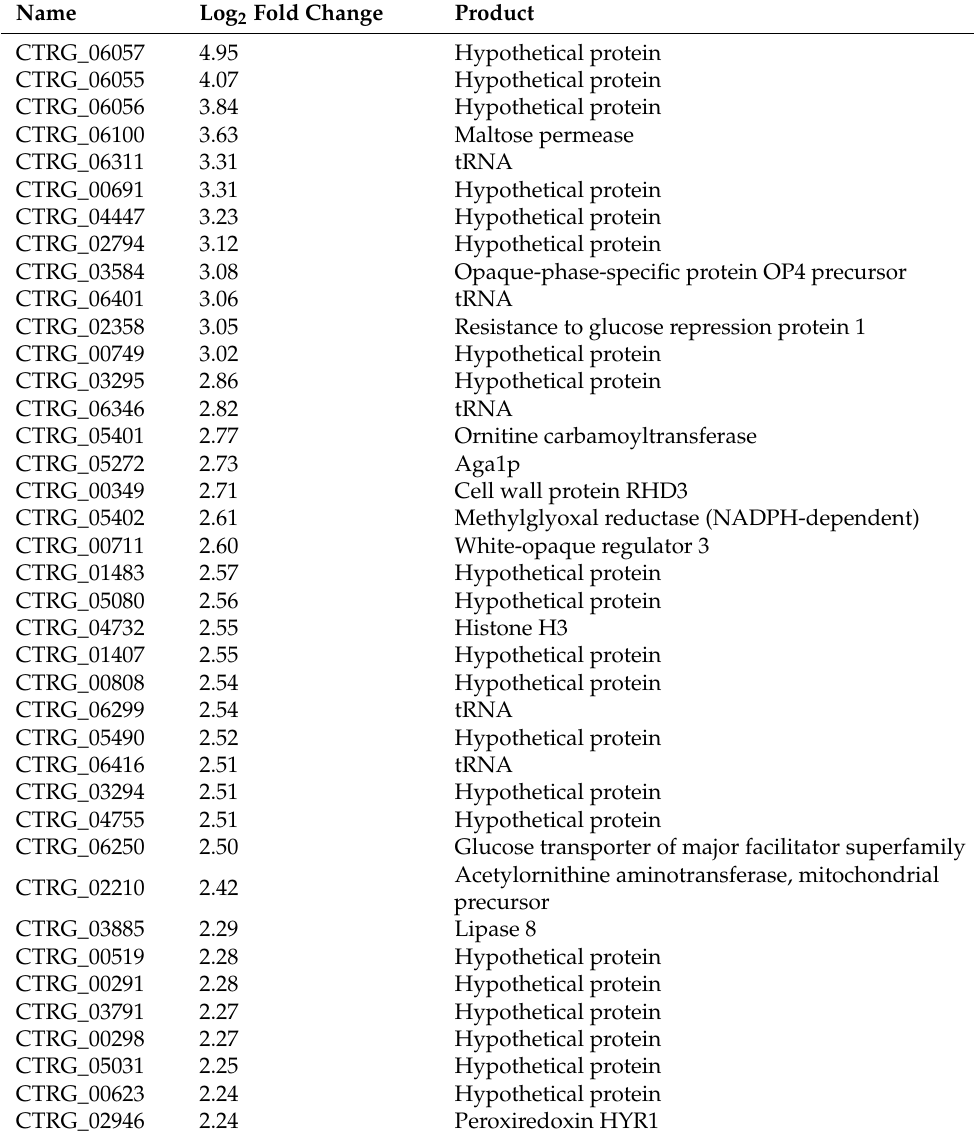
Table 1. Significantly up-regulated genes (log 2 > 2) in the adapted